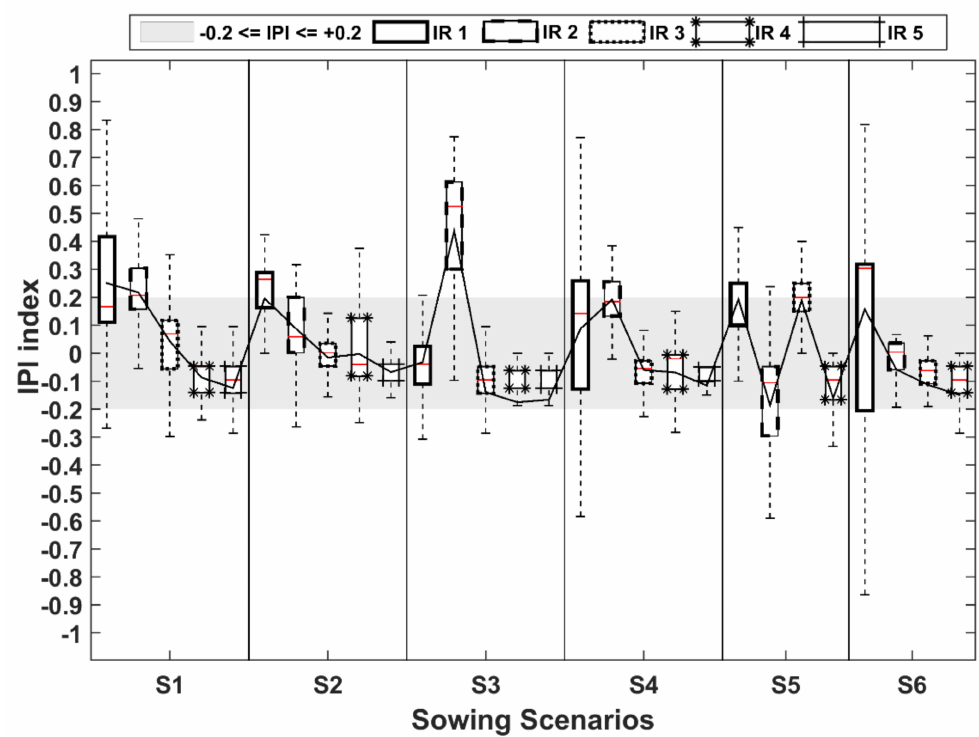
Figure 10. Distribution of the optimized IPI index at plot level for each sowing scenario (IRi represents the irrigation round number in the growing